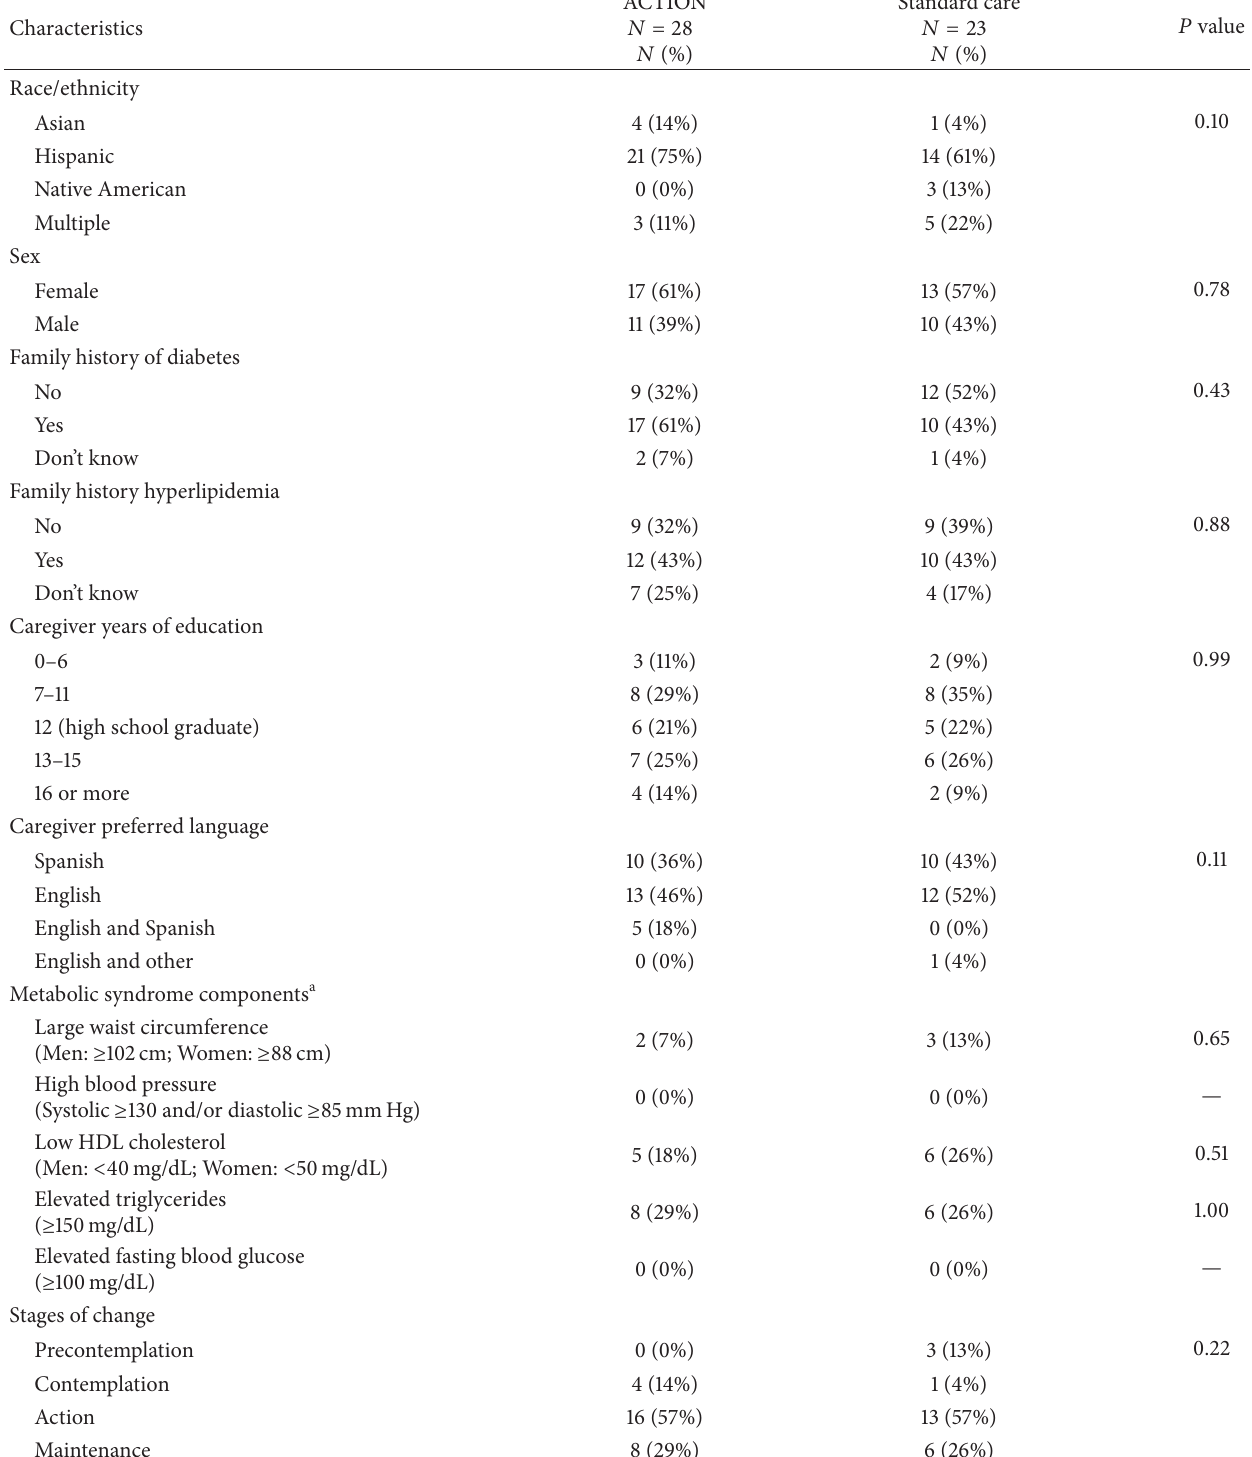
Table 2: Characteristics of the ACTION and standard care groups at